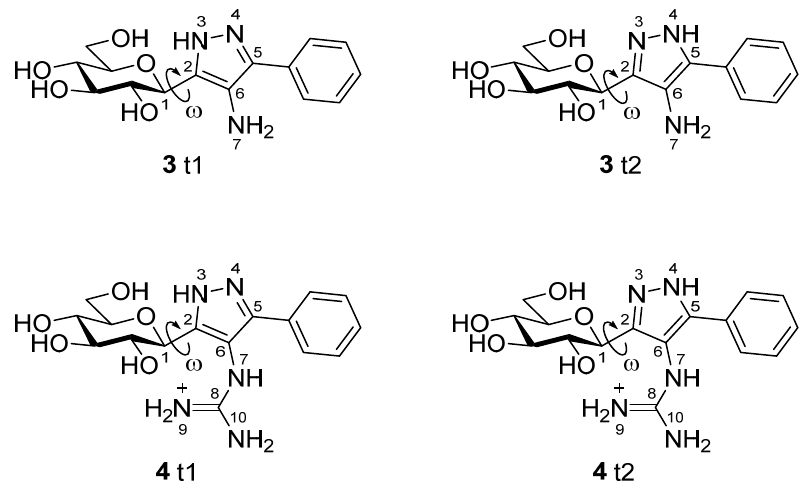
Figure 1. The predicted relevant ionization/tautomeric states of the unbound ligands based on LigPrep, Jaguar pK a and DFT calculations. Rotation around key dihedral angle ω (C 1 H-C 1 -C 2 -N 3 ) for the di ff erent conformations is highlighted. Atoms are numbered for discussion in the text.